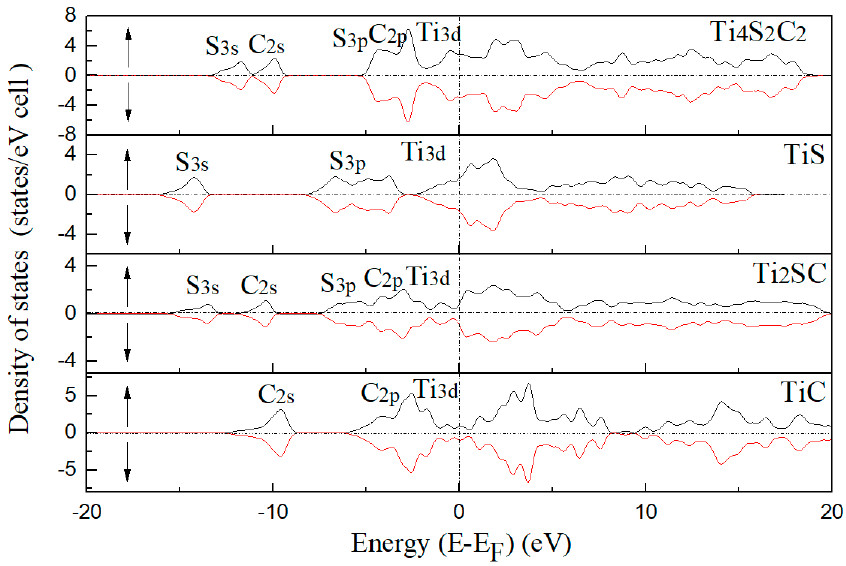
Figure 9. The total density of the states Ti 4 S 2 C 2 , Ti 2 S 2 , Ti 2 SC and Ti 4 C 4.